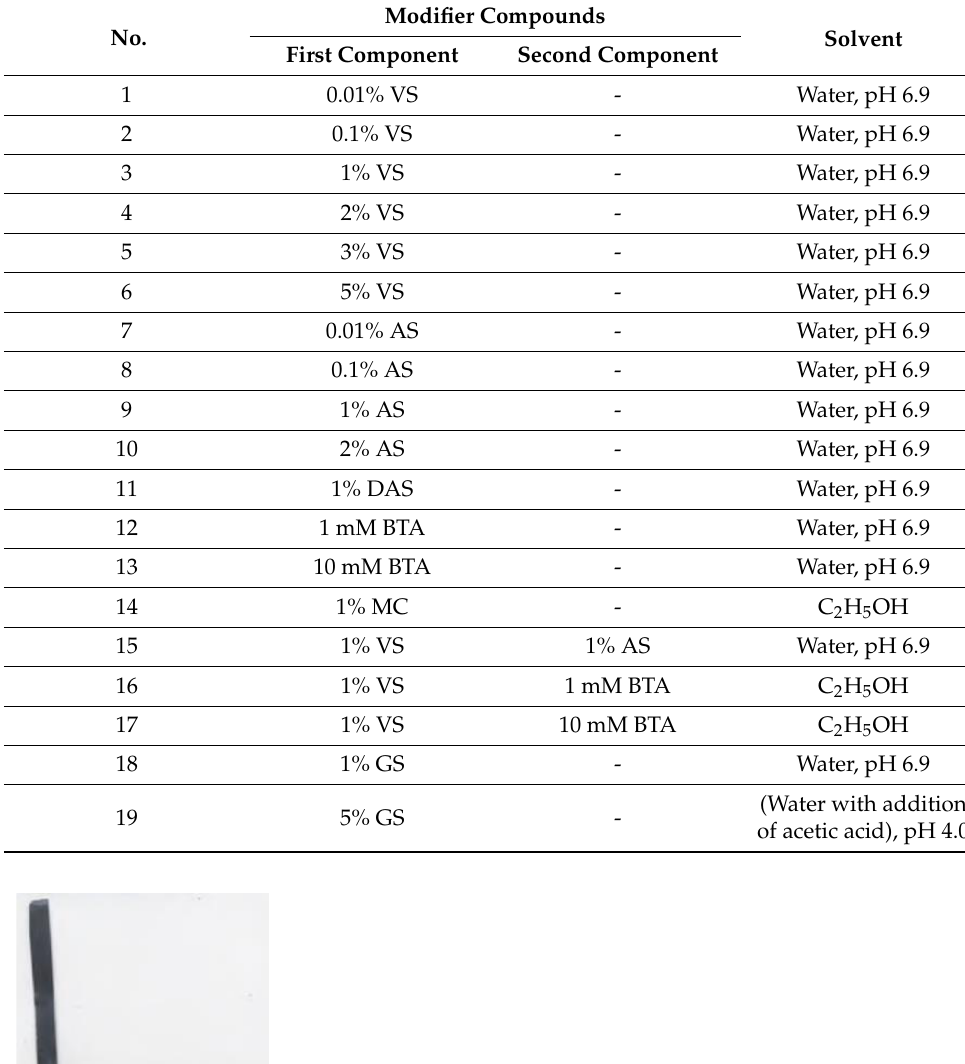
Table 2. Composition of solutions used to modify the surface of metal samples.